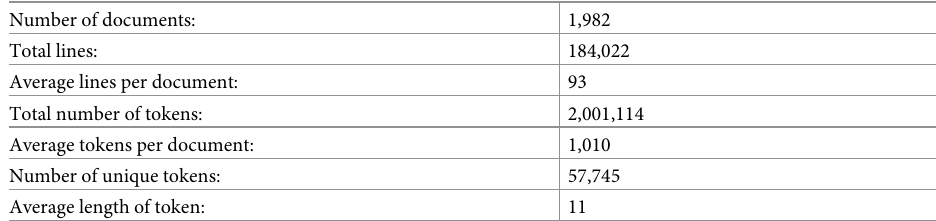
Table 2. Description of